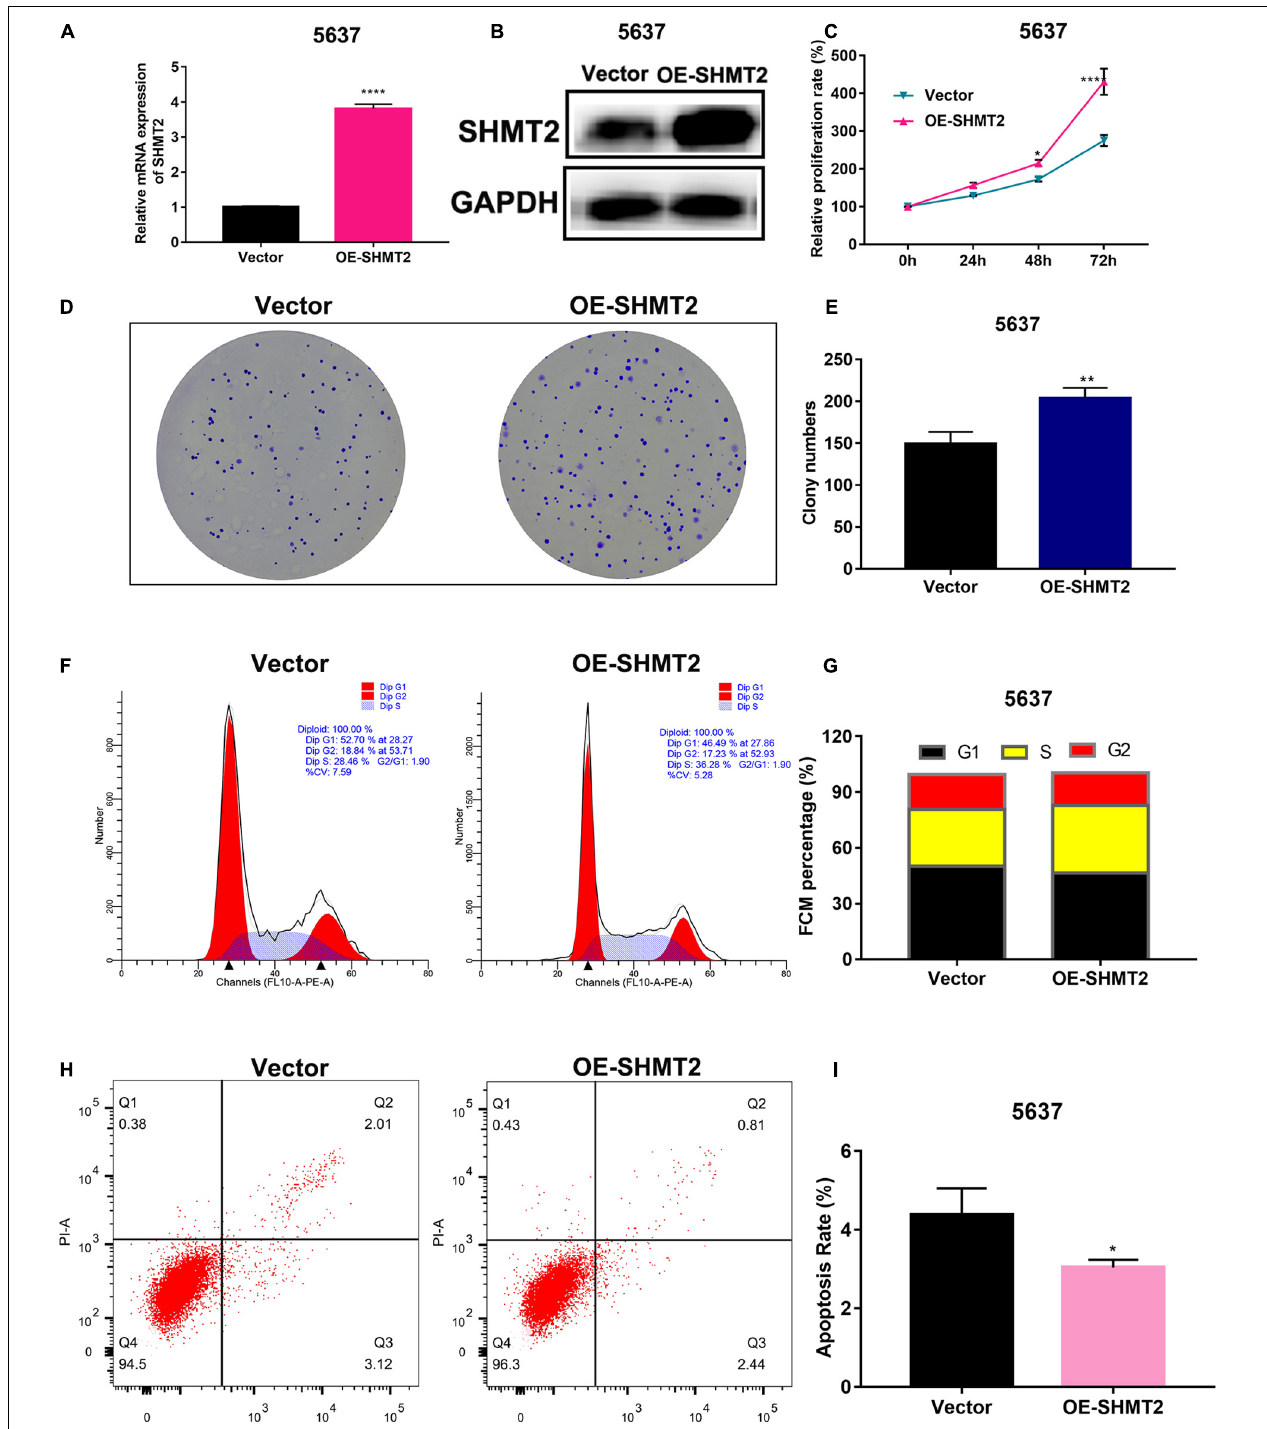
FIGURE 8 | Overexpression of SHMT2 promoted bladder cancer cell proliferation. (A,B) SHMT2 mRNA and protein expression levels were examined in SHMT2-overexpressed 5637 cells (**** P < 0.0001). (C) Overexpression of SHMT2 increased the BLCA cell proliferation rates using CCK-8 assay. ( n = 3, * P < 0.05, **** P < 0.0001). (D,E) Overexpression of SHMT2 increased the colony numbers, graph illustrating quantified values ( n = 3; ** P < 0.01). (F,G) Overexpression of SHMT2 promoted cell cycle progression, distribution of cells in three cell cycle phases was examined by flow cytometry assay, and the graph shows quantification for each phase. (H,I) Overexpression of SHMT2 inhibited the rate of apoptosis, for measurement of apoptotic cells, cells were stained with both AV and PI, and analyzed by an image flow assay, graph illustrating the percentage of apoptotic cells ( n = 3; * P < 0.5). AV, annexin V; PI, propidium iodide, OE, overexpression, P -value < 0.05 was recognized as statistically